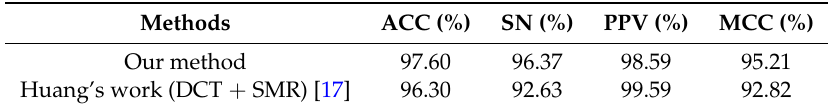
Table 5. Comparison of the prediction performance between our proposed method and other methods on the Human